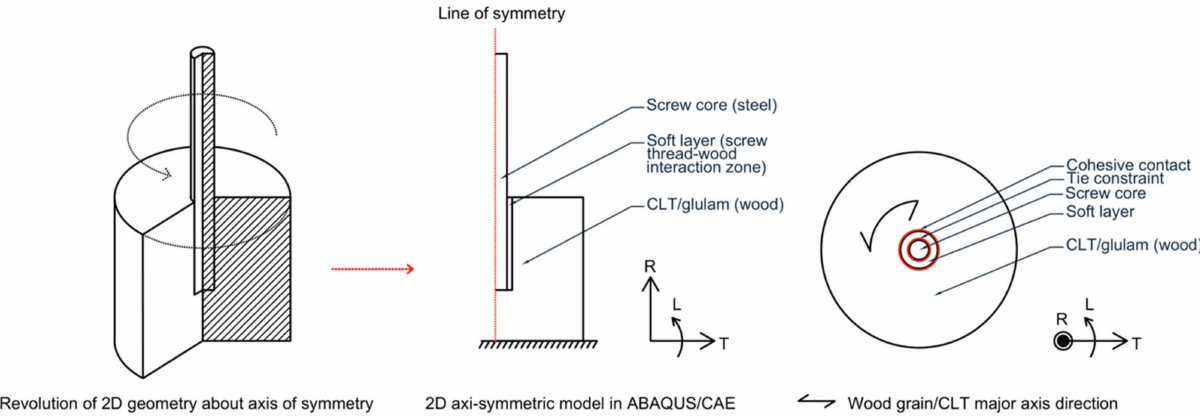
Figure 8. Axisymmetric model in